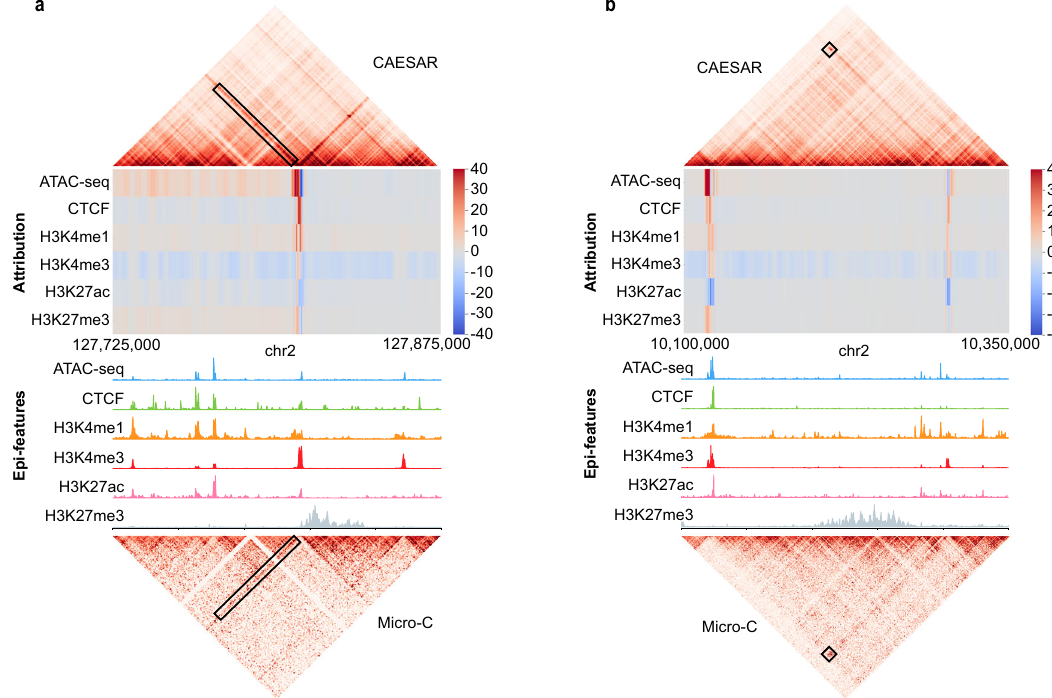
Fig. 6 Attributing CAESAR outputs to epigenomic features via integrated gradient. Larger attribution magnitudes indicate more contribution to the model ’ s prediction. a The signi fi cant attribution of the particular stripe are from its anchor. Although all six epigenomic features have peaks at the anchor locus, the model predicts the stripe mostly from (1) ATAC-seq and CTCF peaks at the anchor, and (2) H3K4me1 modi fi cation surrounding the anchor. b The signi fi cant attribution of the particular loop are from its two anchors. Although H3K27ac have peaks at the left anchor locus, its contribution is negative towards predicting the loop. The CTCF binding at the anchors and H3K4me1/H3K4me3 modi fi cations next to the anchors have positive attribution in predicting the